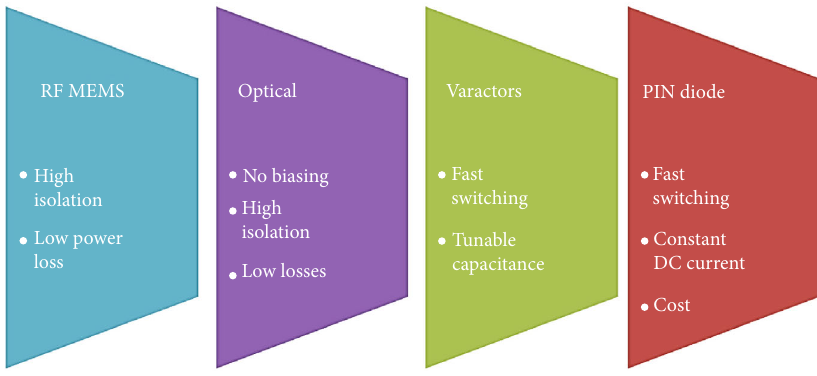
Figure 1: Performance comparison of various